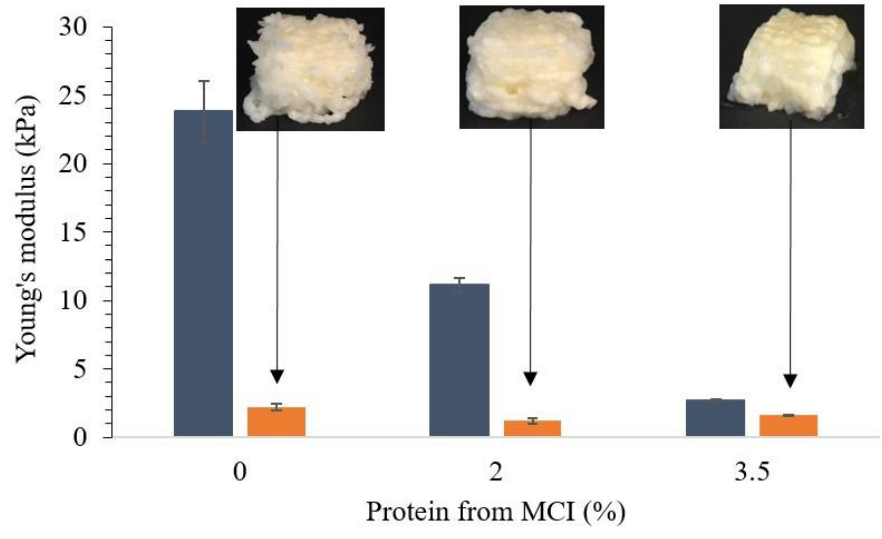
Figure 4. WPI and MCI emulsion gels (10% fat w/w ) with a total protein content of 10%. Emulsion gels formed with 0, 2, and 3.5% protein from MCI and 10, 8, and 6.5% protein from WPI, respectively, before and after 3D printing. Shown are averages of triplicate measurement and error bars as std. deviations.